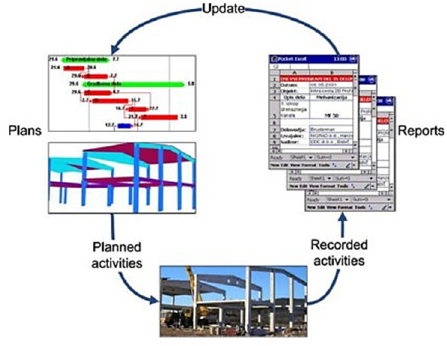
Figure 12. Construction procedures loop [150].